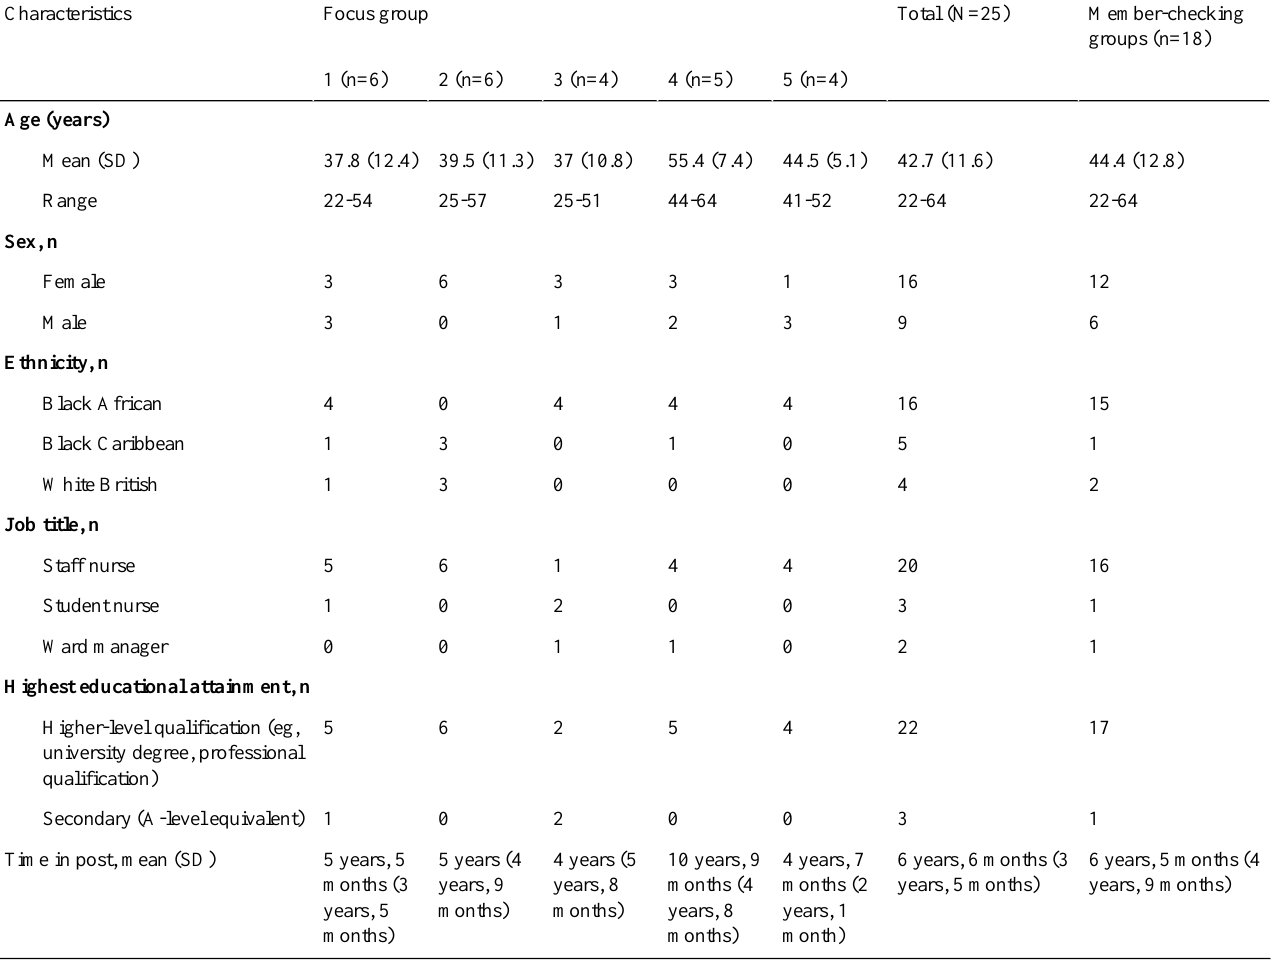
Table 1. Participants’demographic